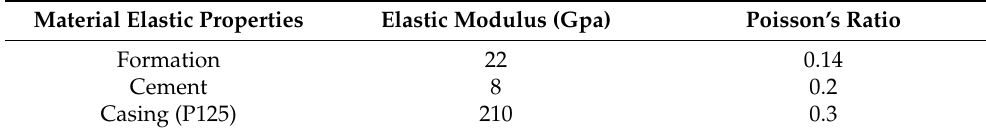
Table 2. Material elastic